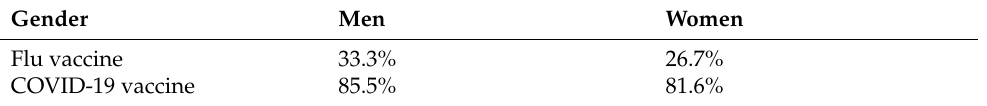
Table 5. Comparison between vaccination for influenza and COVID-19 in